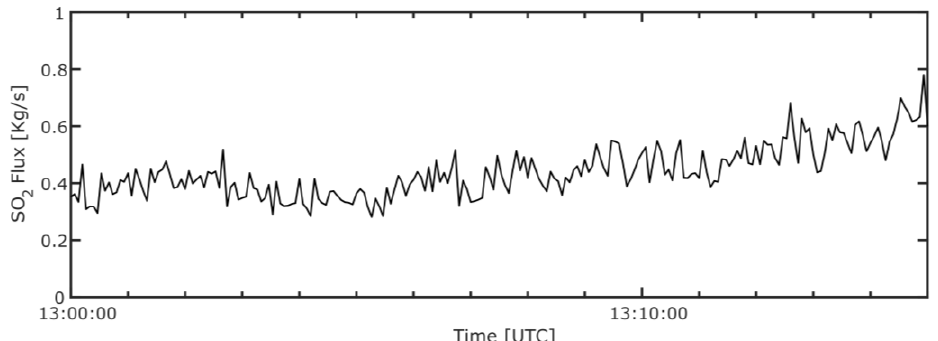
Figure 5. Time series of SO 2 flux from Drax power station for a 15 min acquisition period.